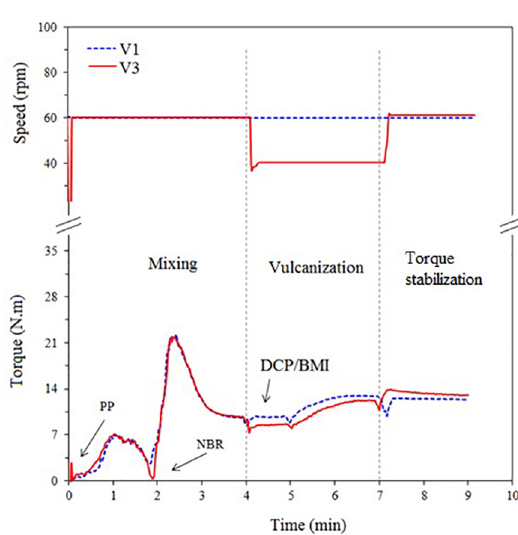
Figure 2. Evolution of actual rotor speed and torque with mixing time as a function of rotor speed profile at dynamic vulcanization of PP/NBR (50/50 phr) TPVs: V1 (blue dashed line) and V3 (red line).